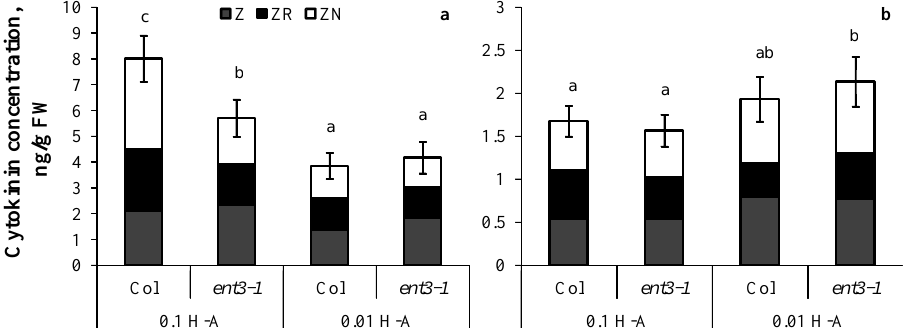
Figure 4. Concentration of zeatin (Z), zeatin riboside (ZR), and zeatin nucleotide (ZN) in roots ( a ) and shoots ( b ) of 5-week-old ent3-1 Arabidopsis mutant and its parent ecotype Columbia (Col) grown in vessels filled with sand saturated with 0.1-strength Hoagland–Arnon solution and sampled 5 days after dilution (0.01 H-A) of optimal 0.1 strength Hoagland–Arnon nutrient solution (0.1 H-A). Statistically differing means (n = 6) are indicated with different letters ( p < 0.05, Students t -test).